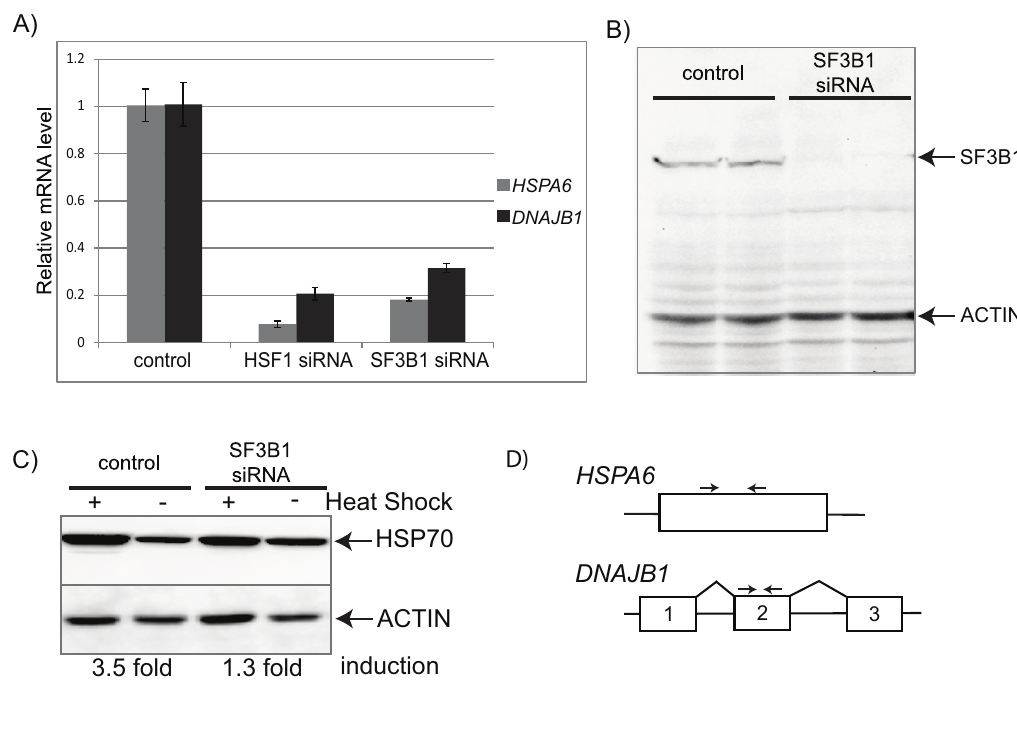
Fig 1. Depletion of SF3B1 inhibits the HSR. (A) qRT-PCR analysisof mRNA levels of two heat shock genes, HSPA6 and DNAJB1 , in cells that have been treated with either HSF1 siRNA or SF3B1 siRNA and subjectedto a 1 hour heat shock at 42˚. Data is shown relativeto mRNA levels in heat shocked cells treated with a nonsilencing control siRNA. (B) Western blot analysisof cells treated with SF3B1 siRNA or a nonsilencing control siRNA probedwith both anti-SF3B1 and anti-ACTIN antibodies.Two biologically independentreplicates for each sample are shown. (C) Western blot analysisof cells treated with SF3B1 siRNA or a nonsilencing control siRNA and probedwith anti-HSP70or anti-ACTIN antibodies. Heat shocked cells were subjectedto a 1 hour at 42˚ and then allowedto recover for 4 hours at 37˚ before harvesting. Inductionlevels of HSP70 were quantitatedby densitometry from the blots and normalized to ACTIN. Fold inductionupon heat shock is shown. (D) Diagramshowingthe qPCR primer locationsfor HSPA6 and DNAJB1